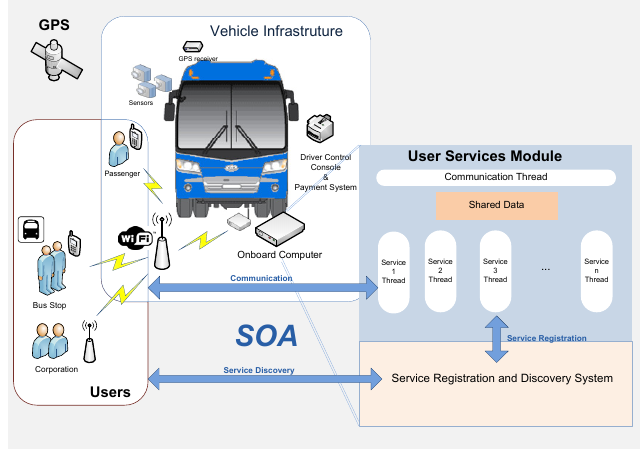
Figure 4. General Service operating schema.